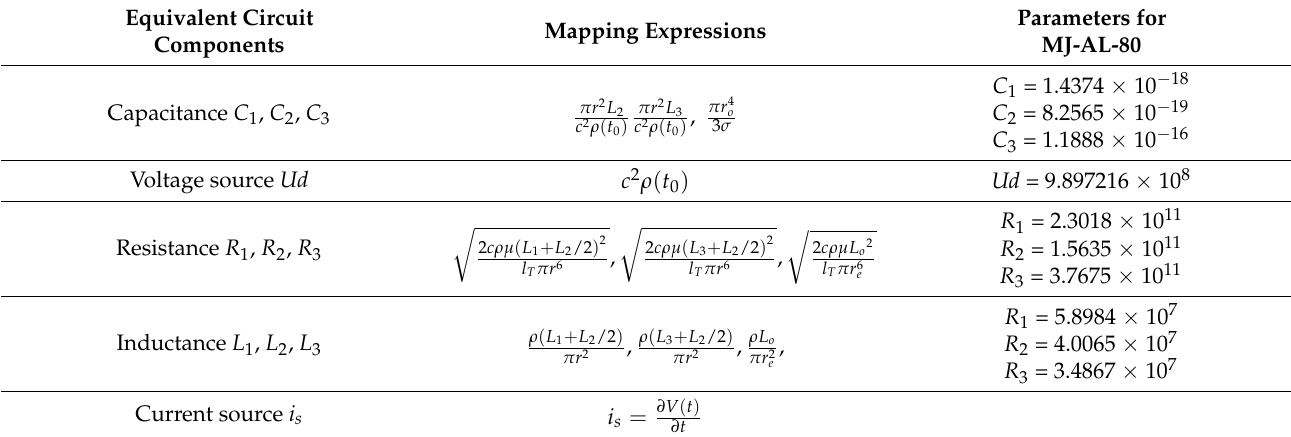
Table 1. Parameters mapping